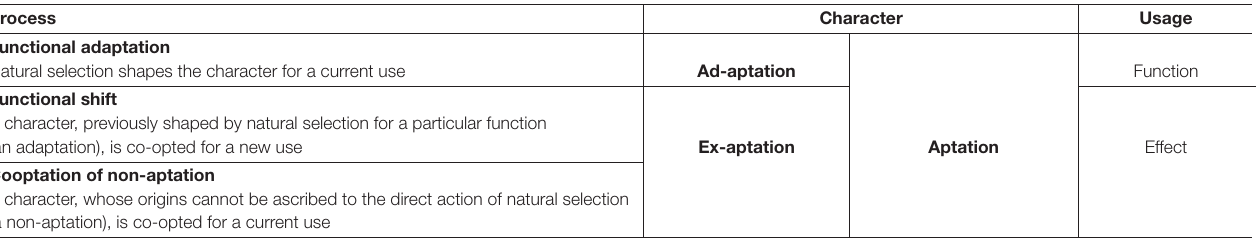
TABLE 1 | A typology of